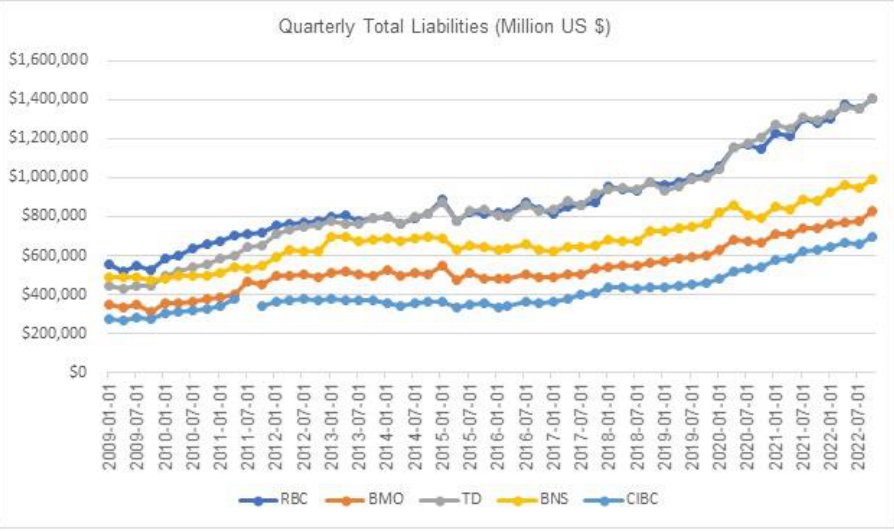
Figure A2. Quarterly total assets of the five banks (Source: Data 2 n.d. https://www.macro- trends.net/stocks/charts, accessed on 12 December 2022).